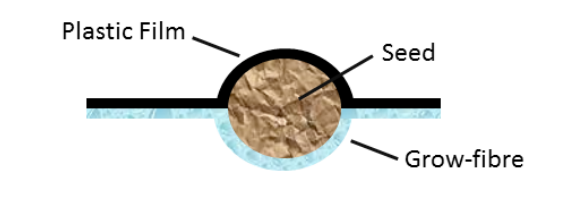
Figure 9: Composition of the cultivation